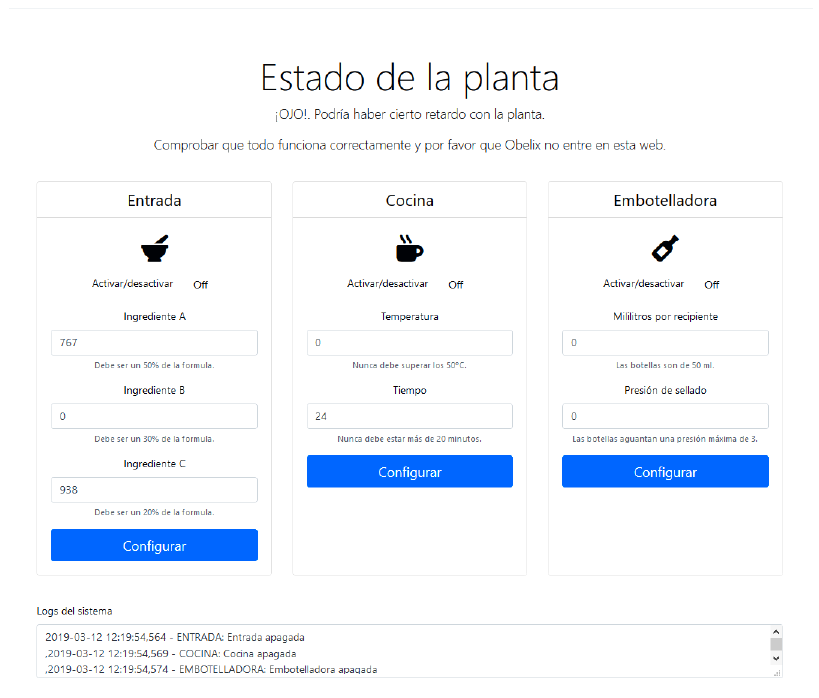
Figure 3. Website of the